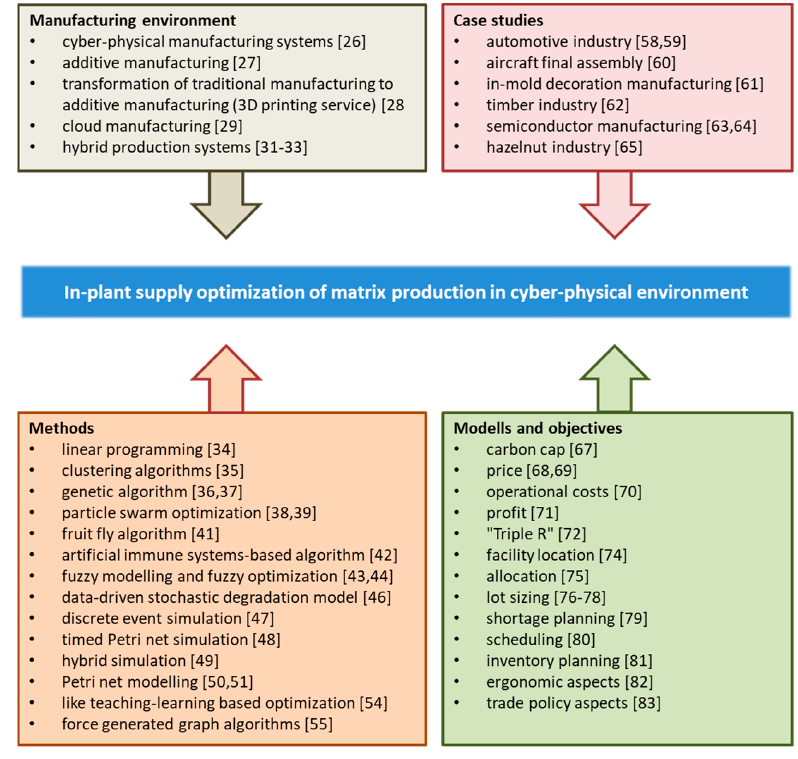
Figure 6. The conceptual framework of published articles.